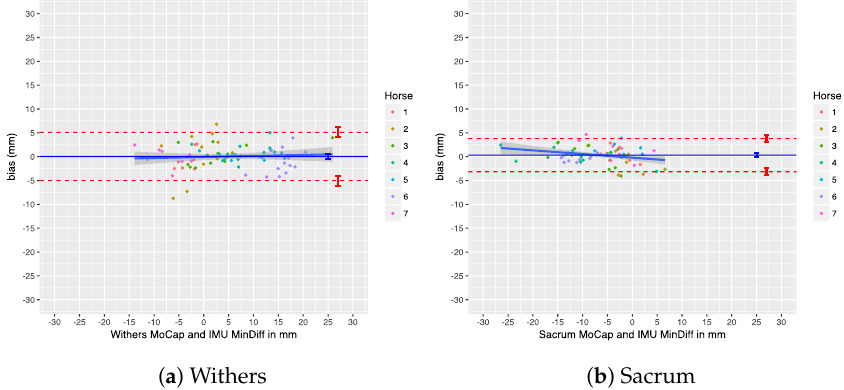
Figure 27. Bland–Altman analysis for Min_diff